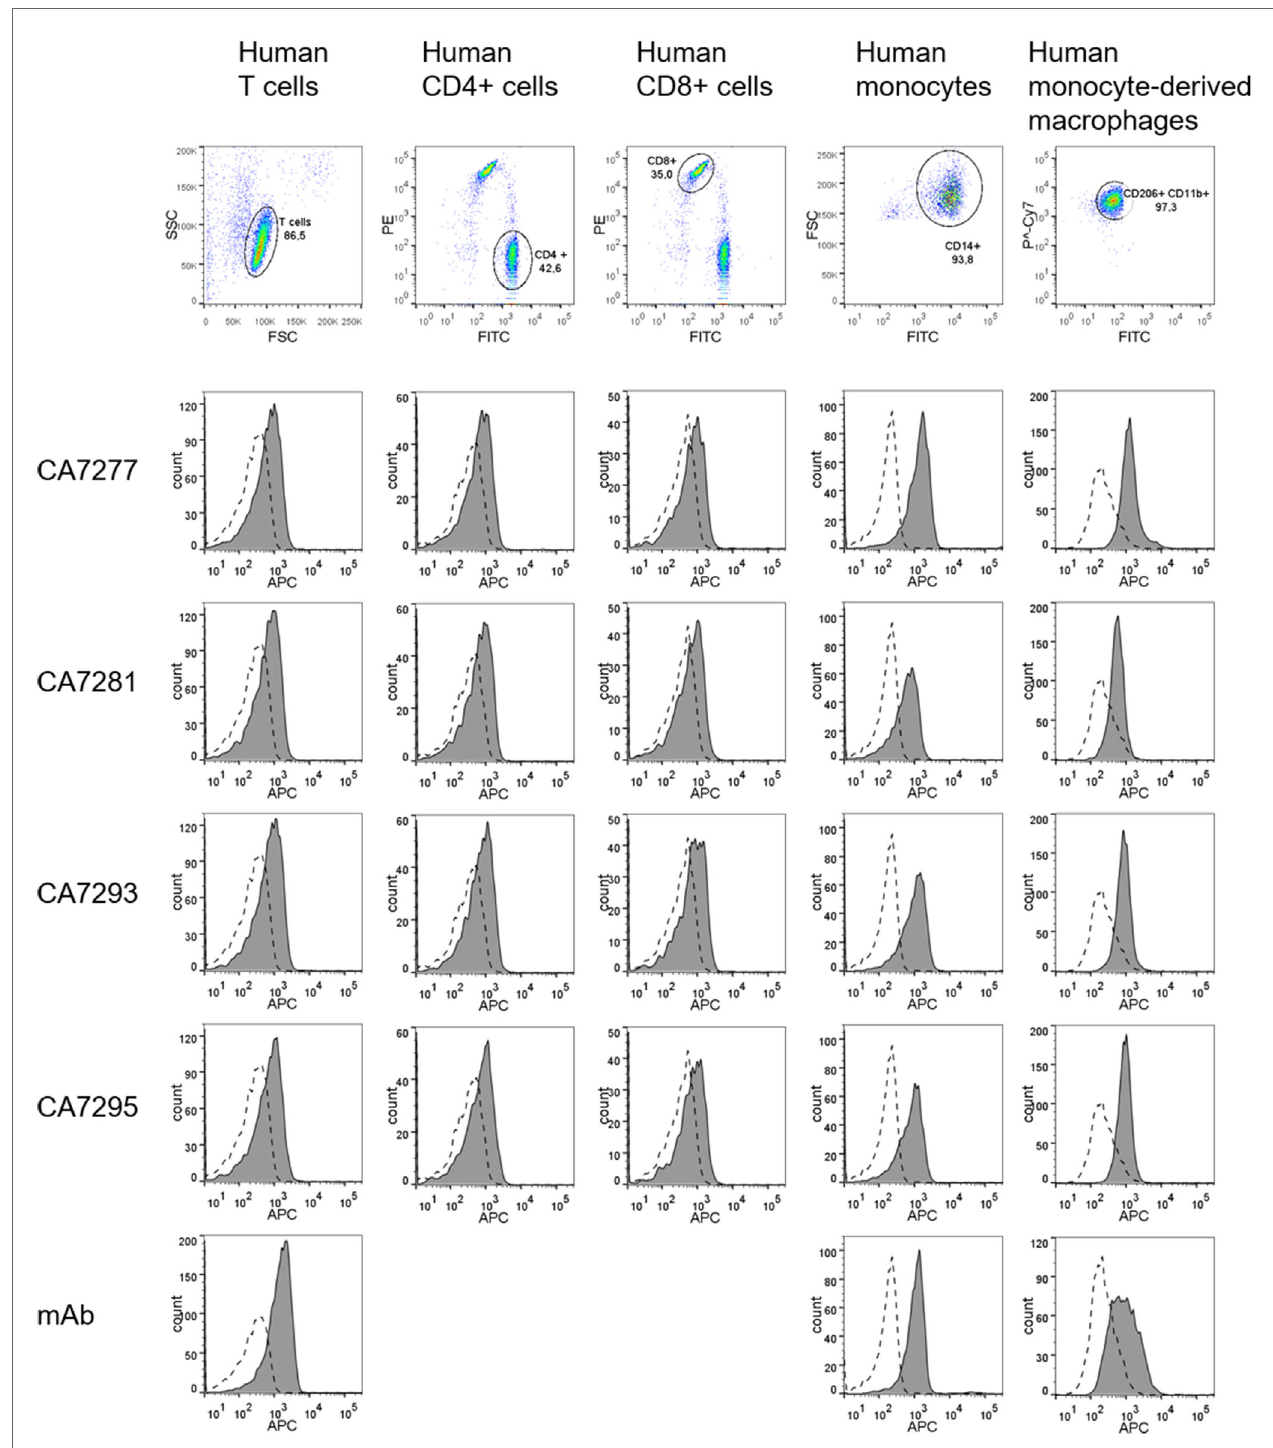
FigUre 7 | Immunodetection of VPAC1 on human primary cells. Cells were stained for leukocyte markers (CD3, CD4, CD8, CD14, CD11b, and CD206) and VPAC1 labeling was investigated on human T cells (first column), CD4 + T cells (second column), CD8 + T cells (third column), monocytes (fourth column), and monocyte-derived macrophages (fifth column), using a reference anti-VPAC1 mouse monoclonal (mAb) and DyLight 650-conjugated nanobodies. The background signal (dotted lines) was evaluated using a control isotype labeled with APC, or a DyLight 650-conjugated irrelevant nanobody. The data are representative of three independent